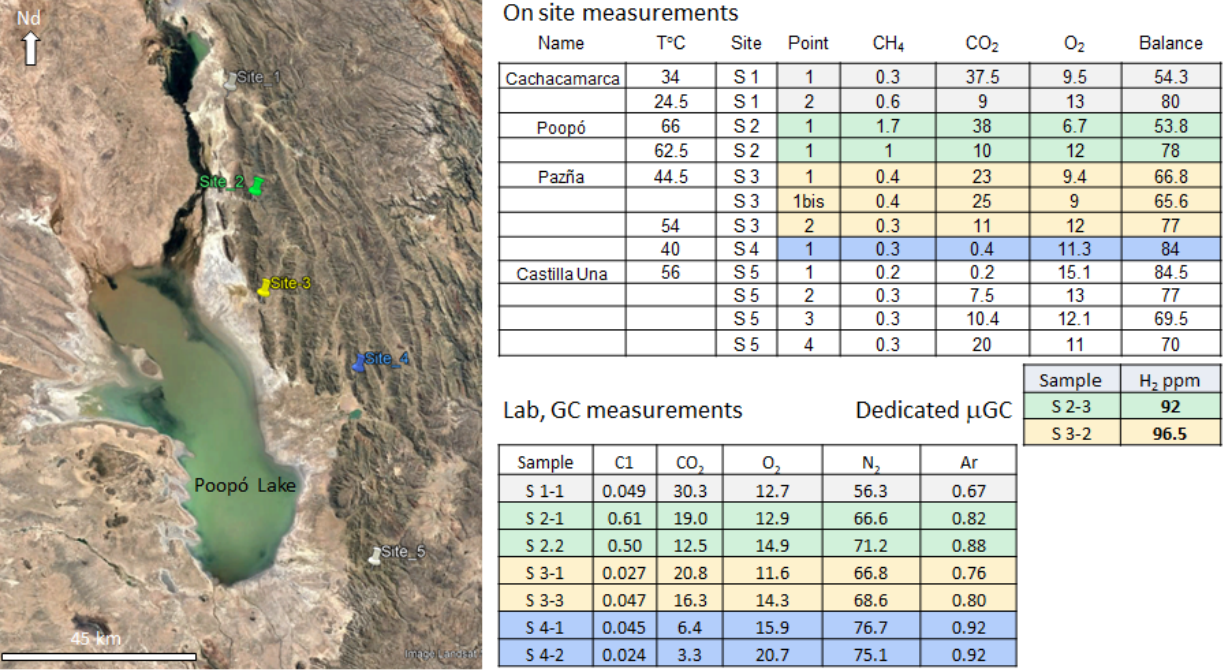
Figure 4. Raw data on-site and in laboratory, without correction. The gas is an N 2 /CO 2 blend with a variable ratio. The color code, different for each site, allows us to quickly link the map and the tables.